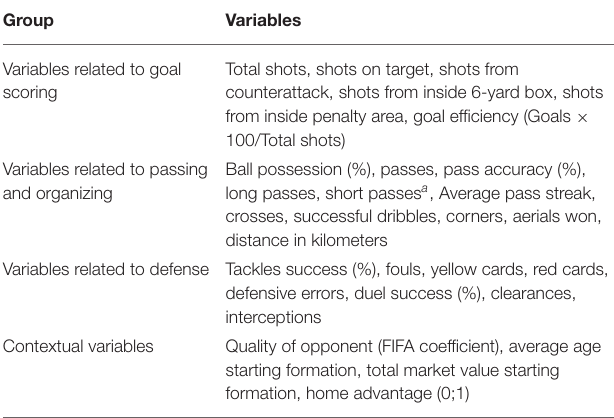
TABLE 1 | Performance variables and contextual variables.